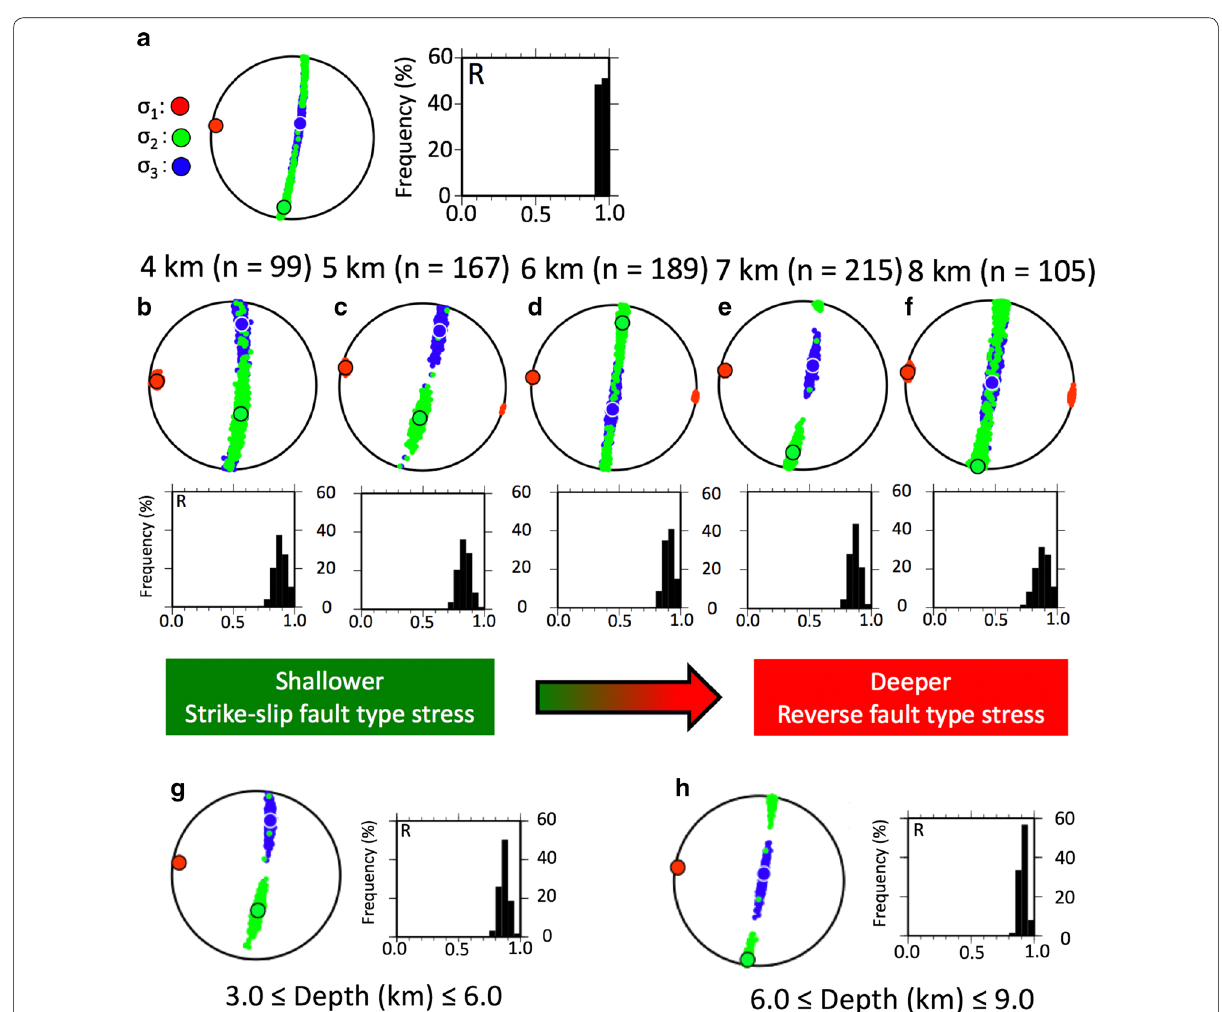
Fig. 9 Stress fields estimated in this study. Stress axis orientations and R -values estimated for the entire study area ( a ), in 1-km depth slices ( b – f ) and in 3-km depth slices ( g , h ) are shown. Principal stress axis orientations and 95% confidence intervals are projected onto lower hemisphere equal- area projections. Red, green, and blue circles correspond to the σ 1 , σ 2 , and σ 3 axes, respectively. Background color of “shallower strike-slip fault-type” and “deeper reverse fault-type stress” indicates fault type; the same color scheme is used throughout this